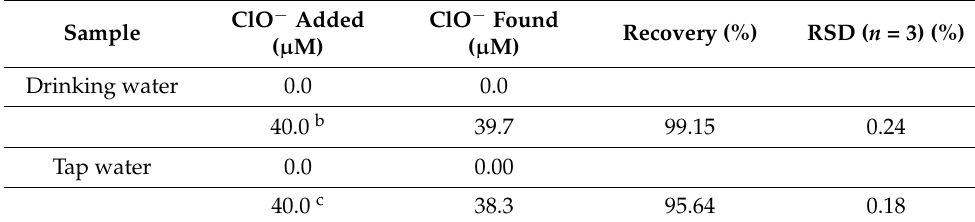
Table 1. Analysis of ClO − a